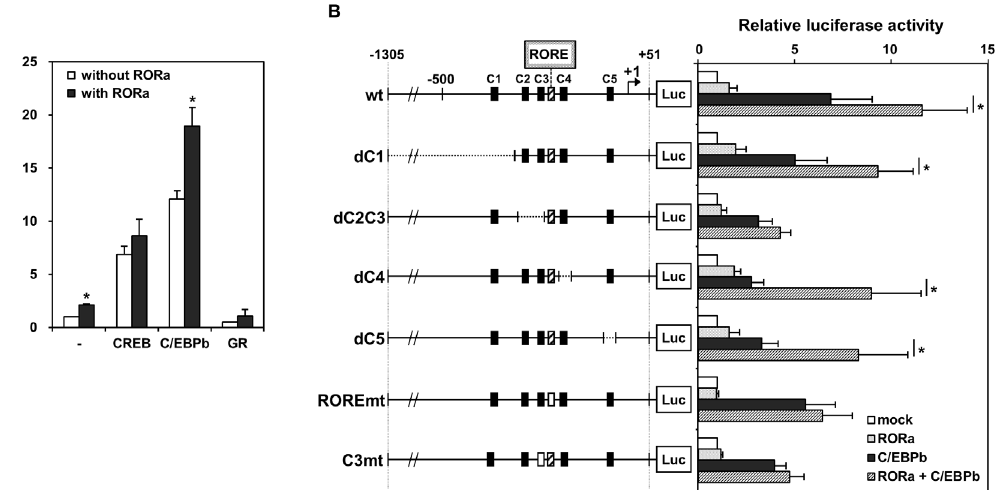
Fig 3. The PEPCK promoter is directly activated by C/EBP β and coactivated by ROR α . (A) Transactivation of the PEPCK promoter by the nuclear receptors CREB, C/EBP β , and glucocorticoid receptor with or without ROR α . HepG2 cells were transfected with luciferase under the control of the PEPCK promoter (-1305 to +51). Data are fold transactivation over basal activity, and are reported as mean ± S.E. (n = 3). (B) HepG2 cells was transfected with ROR α (dotted bars), C/EBP β (closed bars), or both (hatched bars), along with luciferase driven by wild type or mutated PEPCK promoters. Data are mean ± S.E. (n = 3). Mutations in the promoter include deletions of the C1, C4, and C5 binding sites, as well as deletion of both C2 and C3 and mutation of C3 and of the ROR α response element. * , p < 0.05.